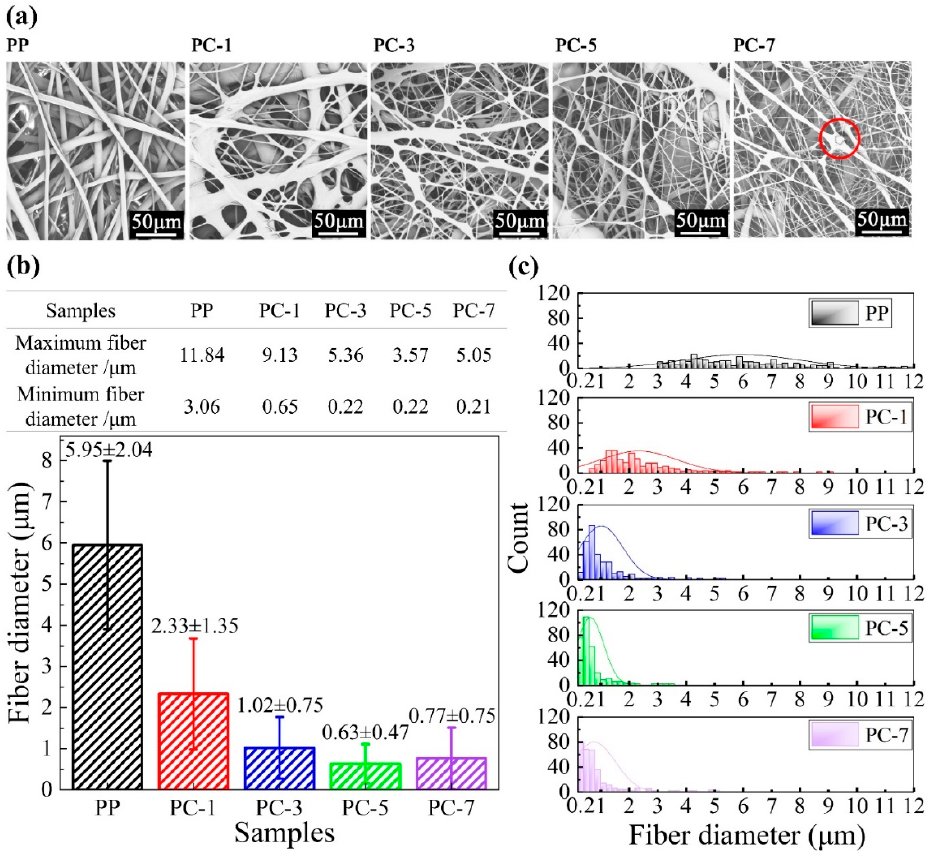
Polymers 2019 , 11 , x FOR PEER REVIEW Figure 4. ( a ) SEM images; ( b ) average fiber diameters (the maximum and minimum fiber diameters are shown in the table); and ( c ) diameter distribution of PP, PC-1, PC-3, PC-5, and PC-7 fibers.